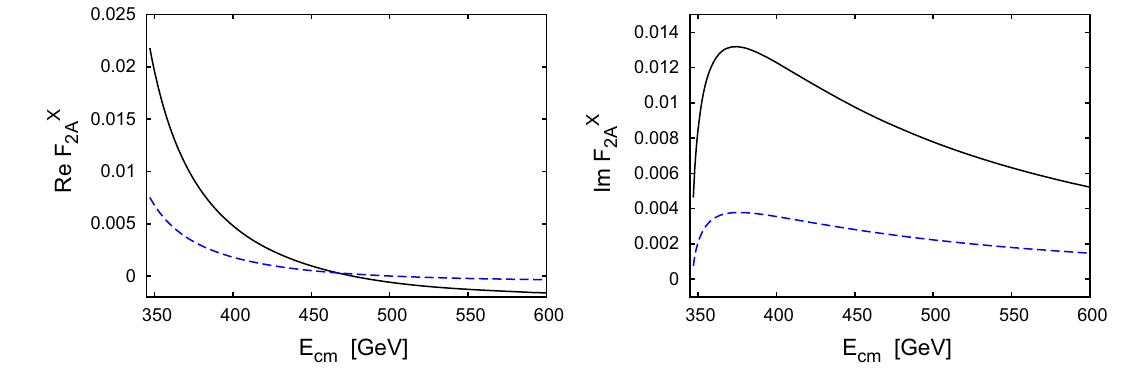
γ m 3 = 600 GeV, as a function of the c.m. energy. Right panel: the same (solid, black) 2 A for the imaginary part of the top-quark EDF and WDF